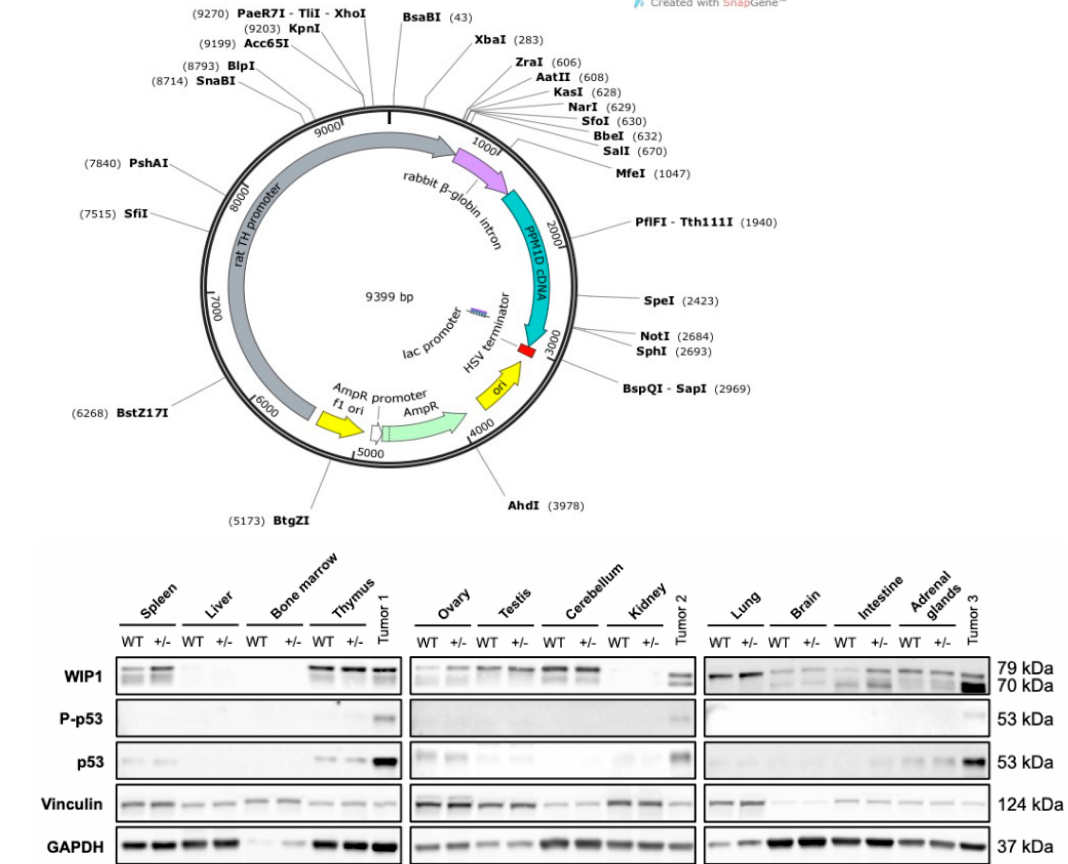
Figure 1. PPM1D -transgenic mice show increased WIP1 expression and develop widespread tumors with wild-type p53 accumulation. ( A ) Transgene construct. Human PPM1D cDNA (blue) PPM1D, ligated downstream of the rat tyrosine hydroxylase promoter (gray) and rabbit β -globin enhancer (violet). Herpes simplex virus (HSV) thymidine kinase gene sequence was used as a transcription terminator (red). ( B ) Thymic lymphoma shows increased WIP1 protein expression, p53 Ser15 phosphorylation, and accumulation of total p53. Protein expression of WIP1 was analyzed in wild-type and PPM1D heterozygous (+/ − ) mouse tissues. Three different mouse thymic lymphoma tumor samples were also included (tumors 1–3). Vinculin and GAPDH protein levels were used as loading controls.